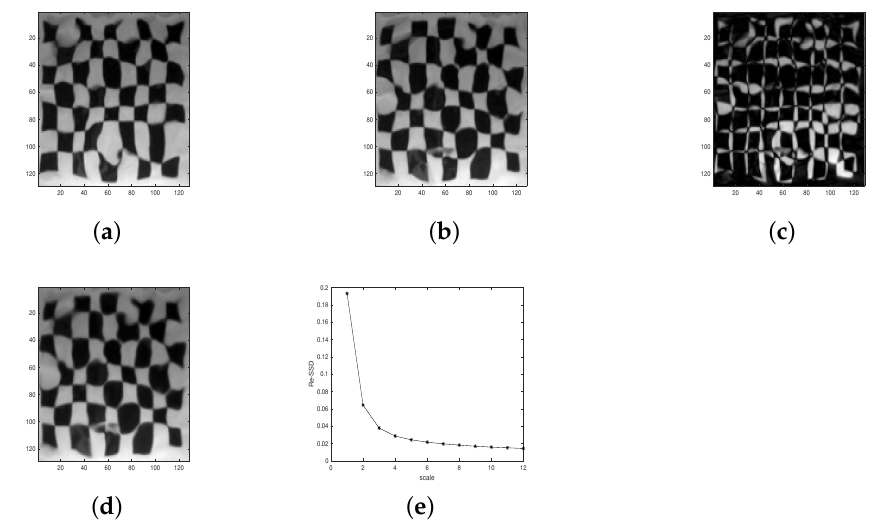
Figure 11. Registration result of Algorithm 2 on image pairs Underwater square. ( a ) T ( · ) . ( b ) D ( · ) . ( · ) . ( e ) Re − SSD change (Underwater square) with scale number. ( c ) | T − D | . ( d ) T ◦ ˆ h K M